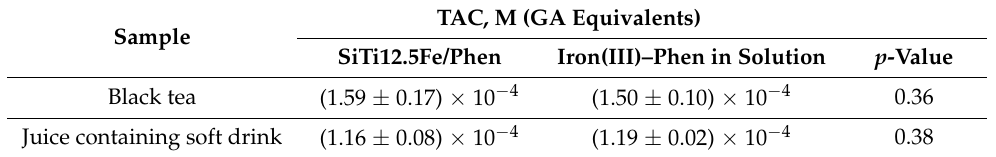
Table 5. Total antioxidant capacity determination in beverages using SiTi12.5/Phen as sensor material (n = 3, P = 0.95).